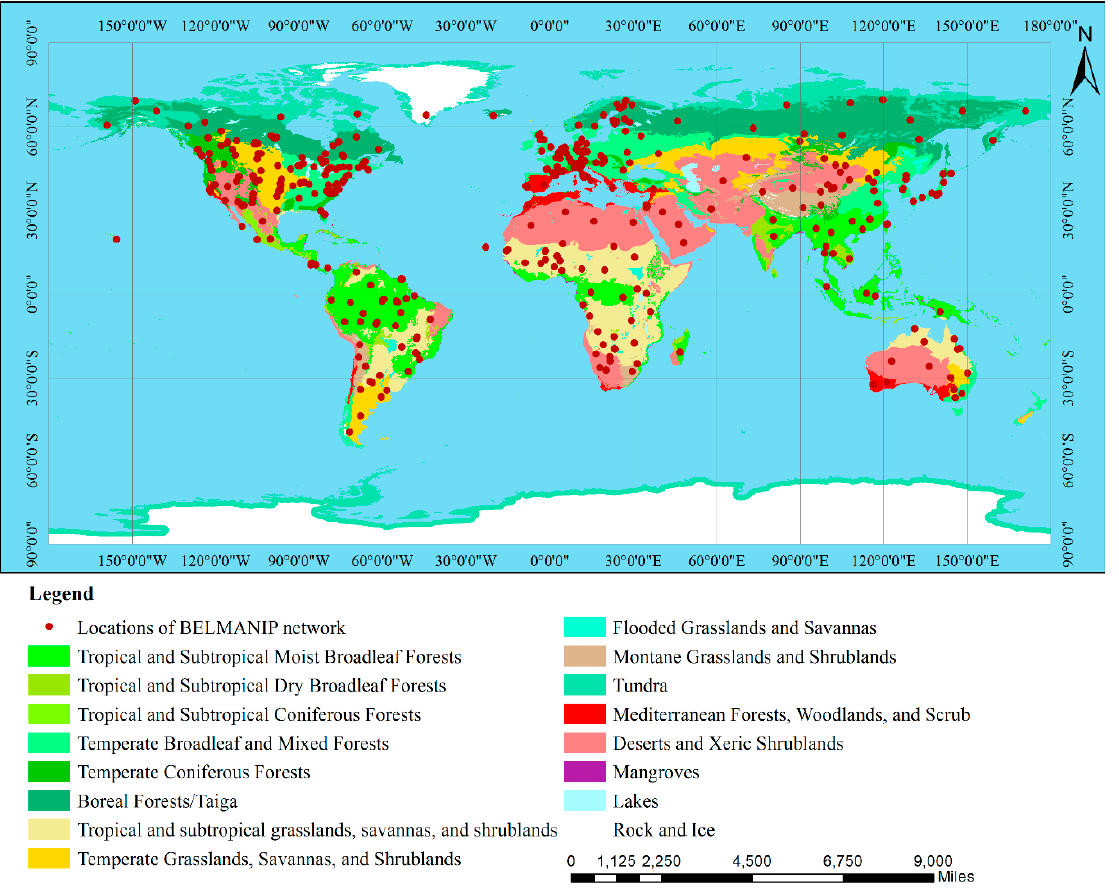
Figure 1. Global sample locations from the Benchmark Land Multisite Analysis and Intercomparison of Products (BELMANIP) network.